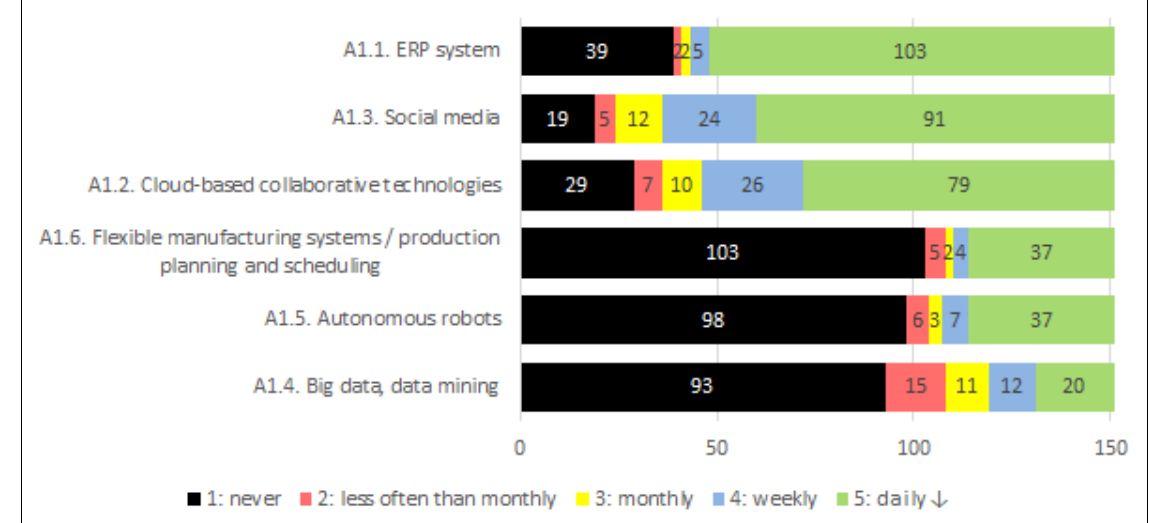
Figure 5. The frequency of the use of CDTs (A1,